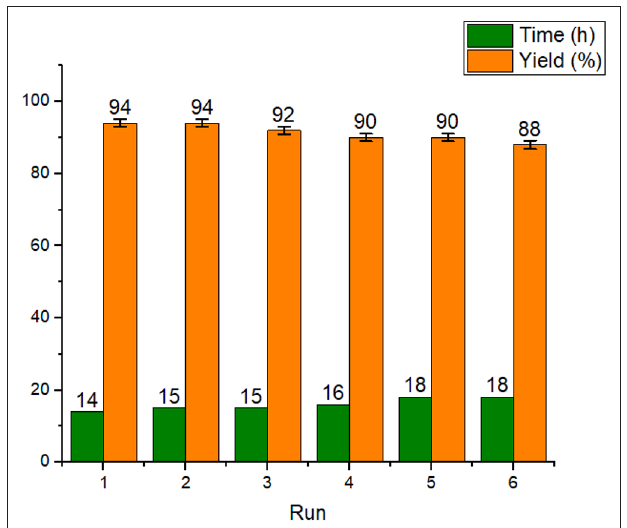
TABLE 3 | The comparison study between the efficiency of the present catalyst with that of other catalysts a